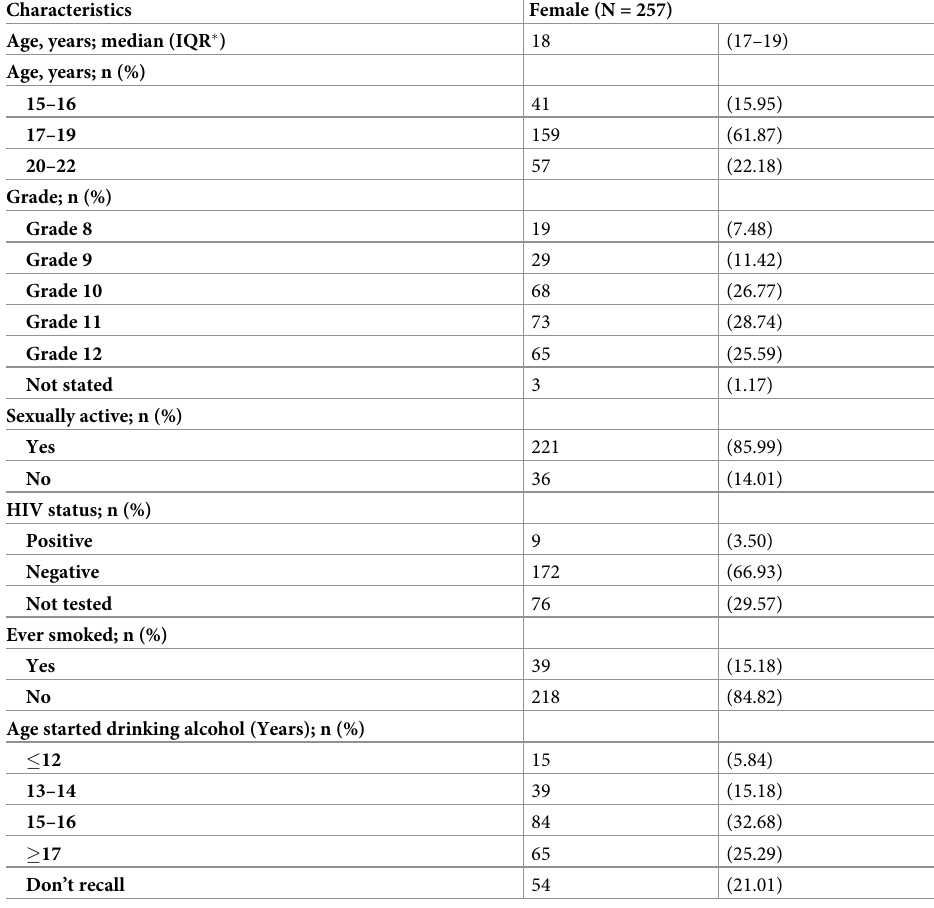
Table 1. Brief demographic characteristics of high school learners who visited the clinic.